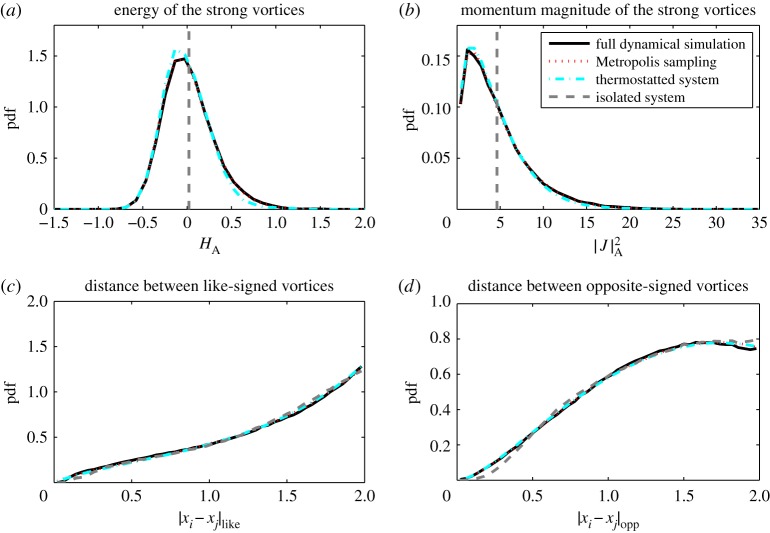
Histograms for Hfull≈0. Panel layouts same as figure 1. (Online version in colour.)